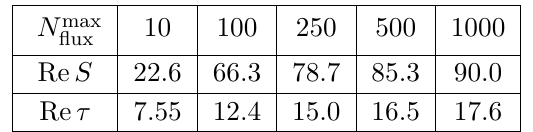
Table 13 . Probabilities (%) of the CP-breaking vacuum expectation value of the axionic (cid:12)elds for various N max (cid:13)ux